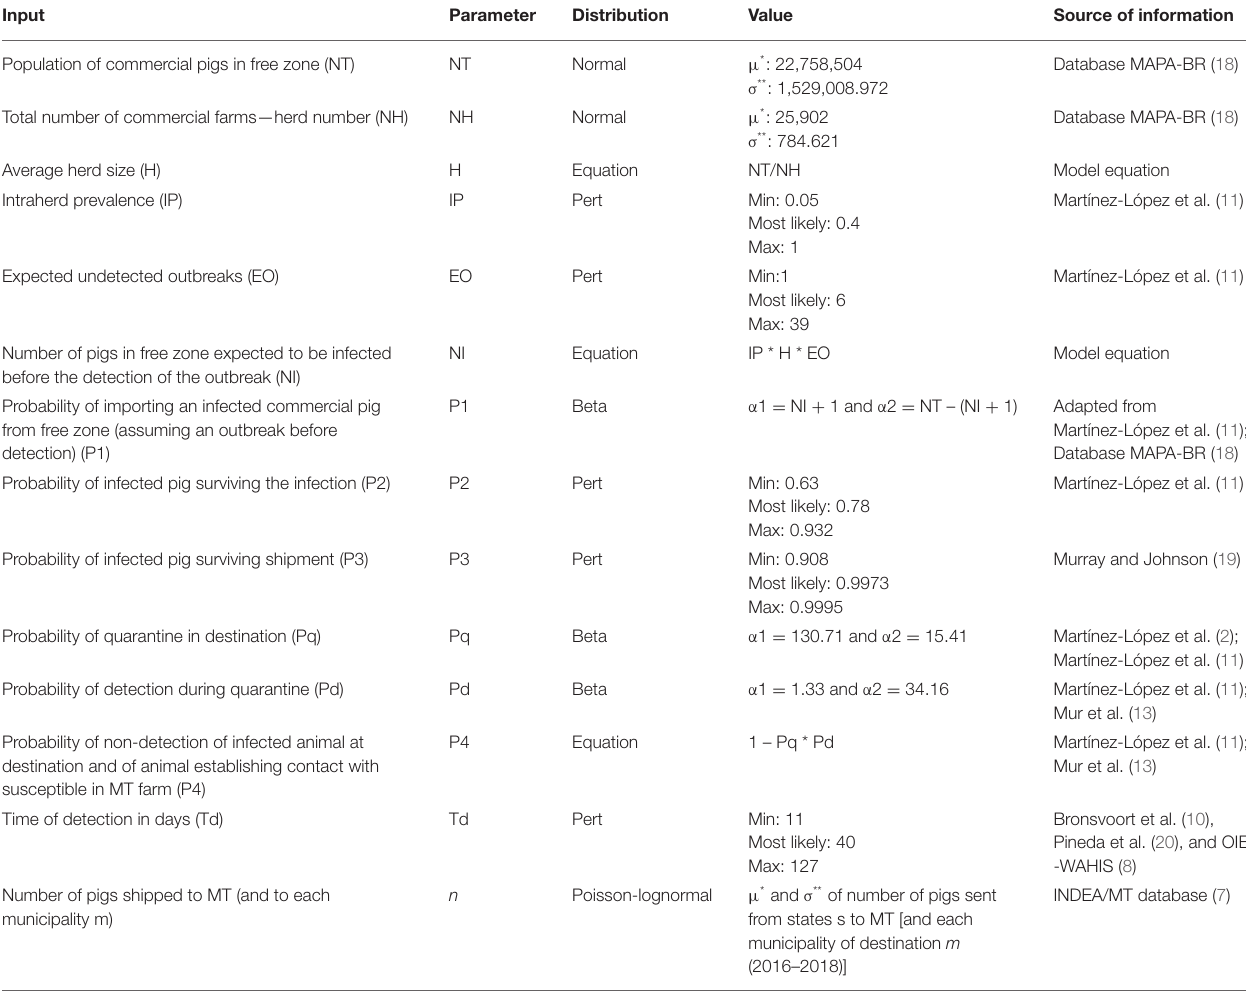
TABLE 1 | Parameterization of a quantitative assessment of the risk of introduction of classical swine fever (CSF) into the state of Mato Grosso (MT), via legal movement of pigs and assuming a CSF outbreak in the disease free-zone of